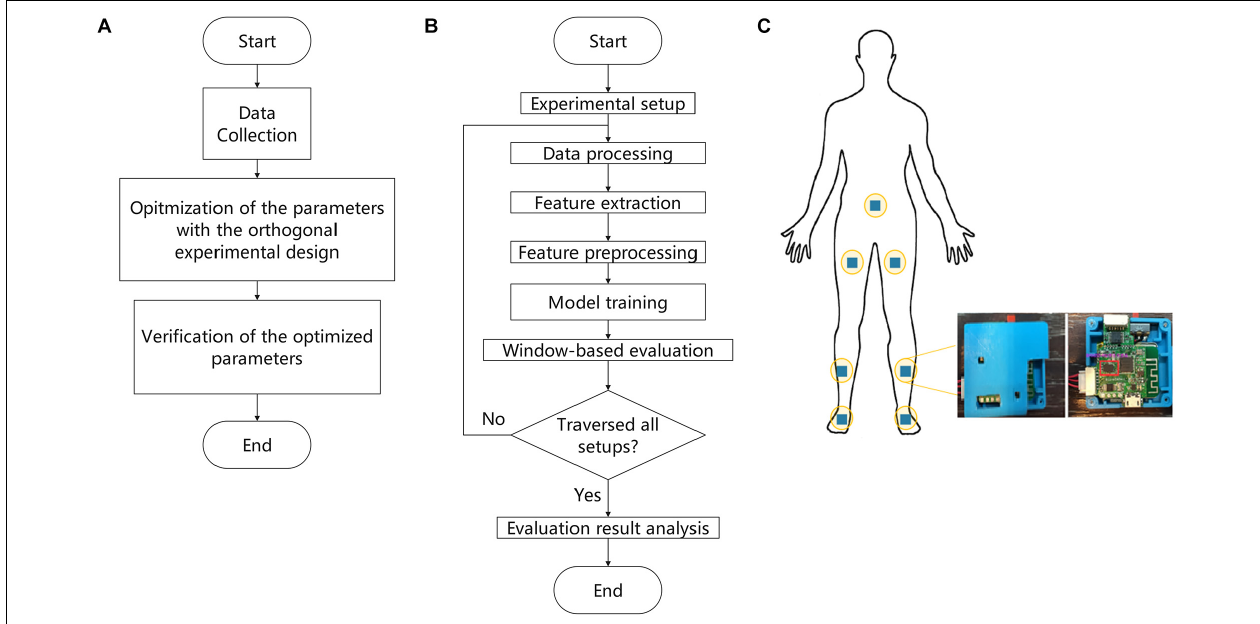
FIGURE 1 | Flowchart of the proposed methodology. (A) Main experimental workflow. (B) Details of the parameter optimization process by means of the orthogonal experimental design (OED). (C) Schematic overview of the positions of the sensors.